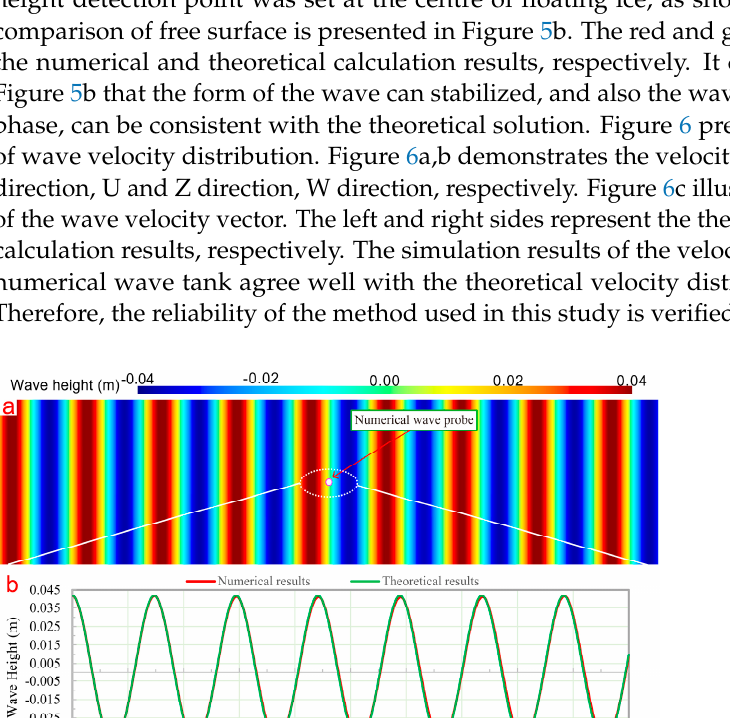
Figure 5. Comparison and verification of free surface wave height. ( a ) Waveform and wave height detection point; ( b ) Comparison of free surface wave height.